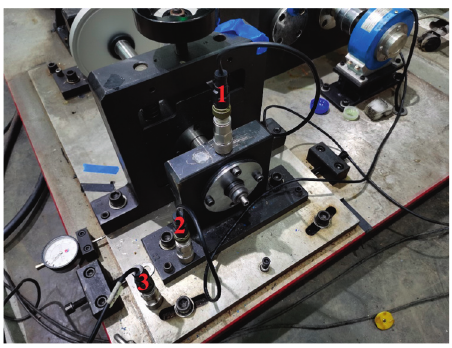
Figure 13: Sensor installation position for bearing inner ring fault simulation experiment.